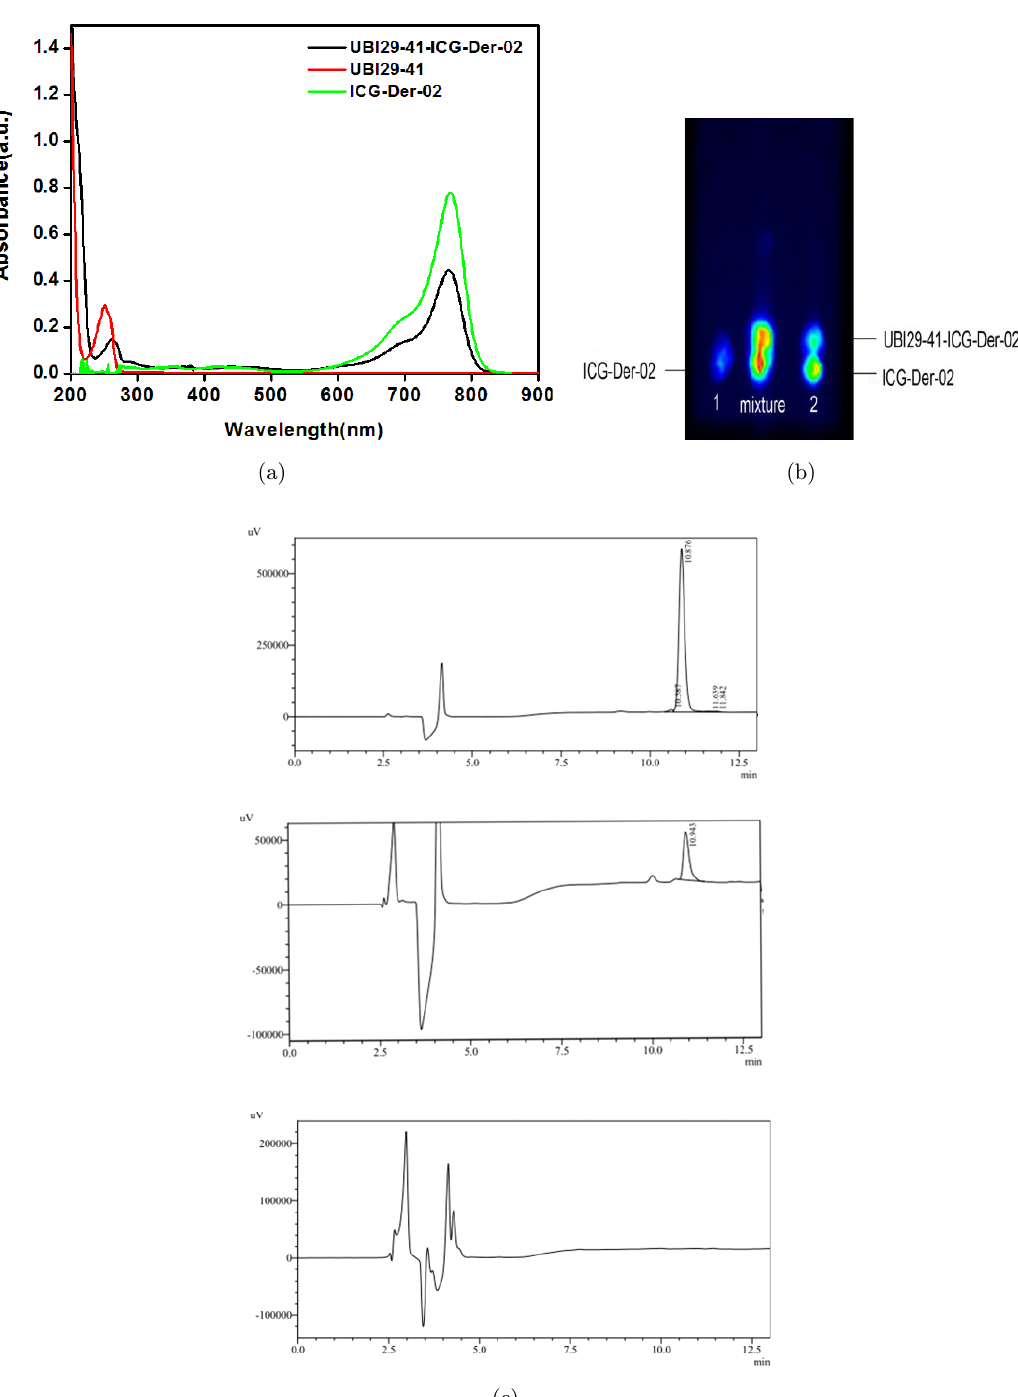
Fig. 2. Characterization of UBI29-41-ICG02. (a) Absorption spectra of synthesized UBI29-41-ICG02 probe and UBI29-41 and ICG-Der-02 dye. The absorption peaks of UBI29-41-ICG02 overlaps the peaks of UBI29-41 and ICG-Der-02 at 256 and 780 nm, indicating the successful conjugation of UBI29-41-ICG02. (b) TLC (dichloromethane: methanol ¼ 5:1) of the UBI29-41-ICG02. The two right spots from the reactants on the right column represents the unreacted ICG-Der-02 (bottom spot) and the product UBI29- 41-ICG02 (top spot). (c) HPLC pro¯les of UBI29-41-ICG02. The top is UBI29-41. The middle was the physical mixture of the UBI29-41 and the ICG-Der02. The bottom was the conjugate UBI29-41-ICG02. And the retention time on analytical HPLC for UBI29-41 was found to be 10